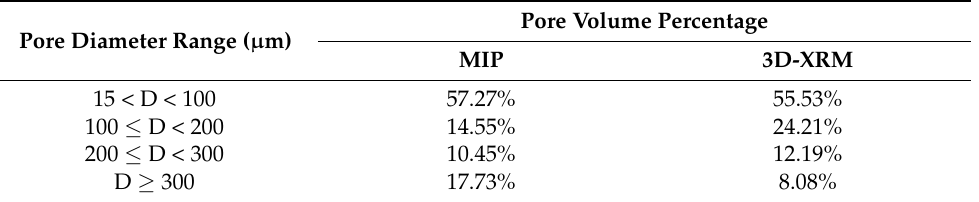
Table 4. Pore volume percentages within different diameters of W2L1-28d by MIP and 3D-XRM test (D > 15 µ